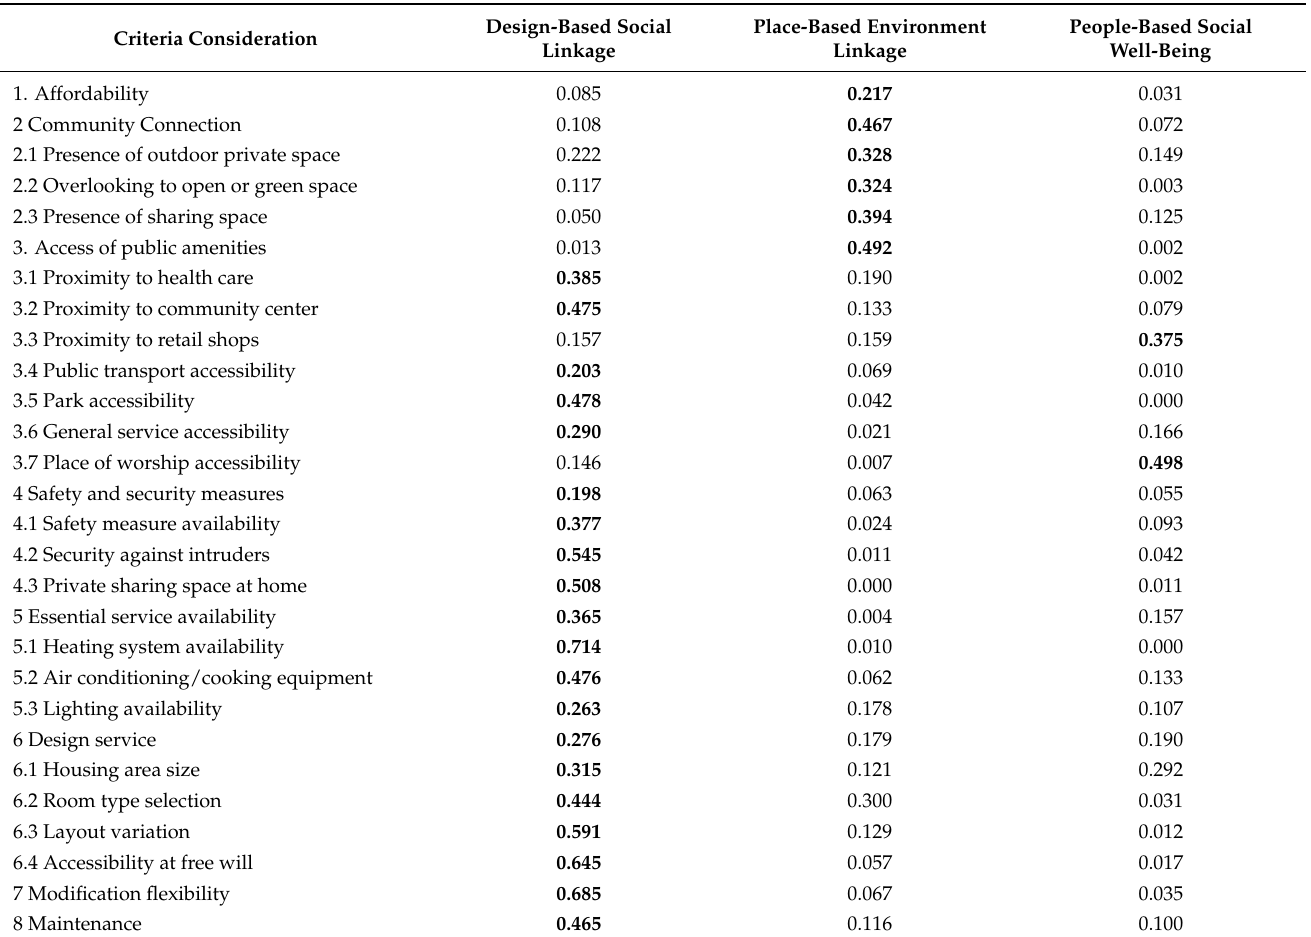
Table 1. Factor analysis resulting in three main